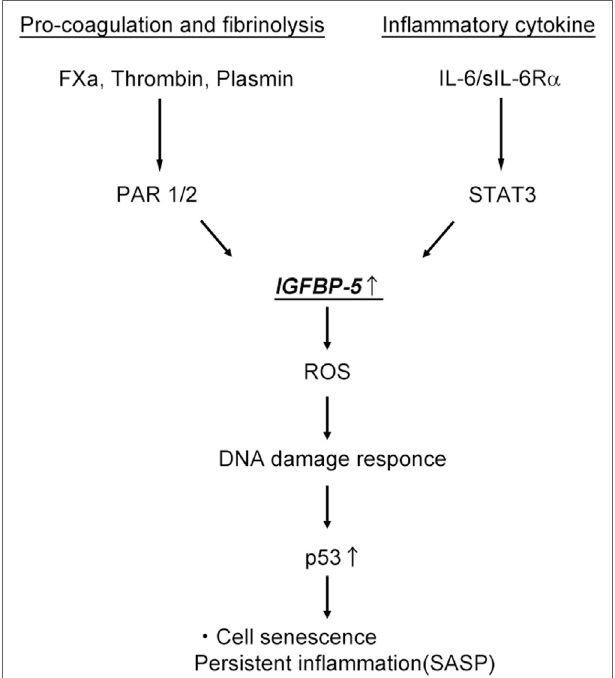
FiGURe 2 | Activation of the pro-coagulation cascade and interleukin-6 (IL-6)/signal transducer and activator of transcription (STAT3) pathway induce cell senescence and persistent inflammation through IGF binding protein-5 (IGFBP-5). ROS, reactive oxygen species; SASP, senescence-associated secretory